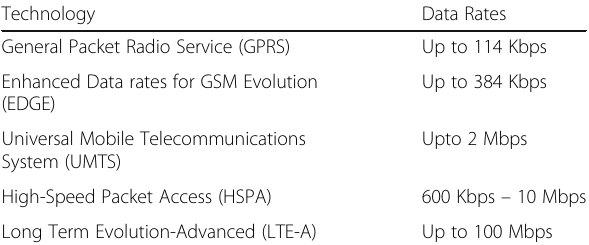
Table 1 Cellular Technologies for Synchrophasor